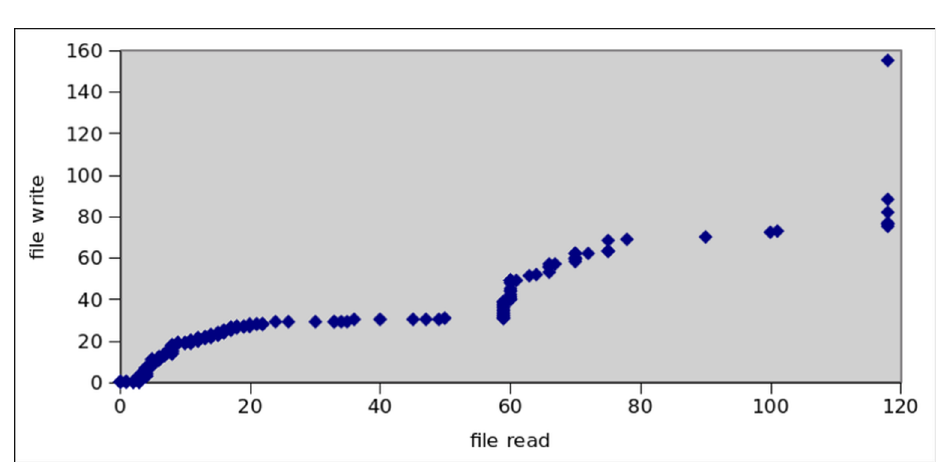
Fig 16. Average File Read/Write operations by malwares.